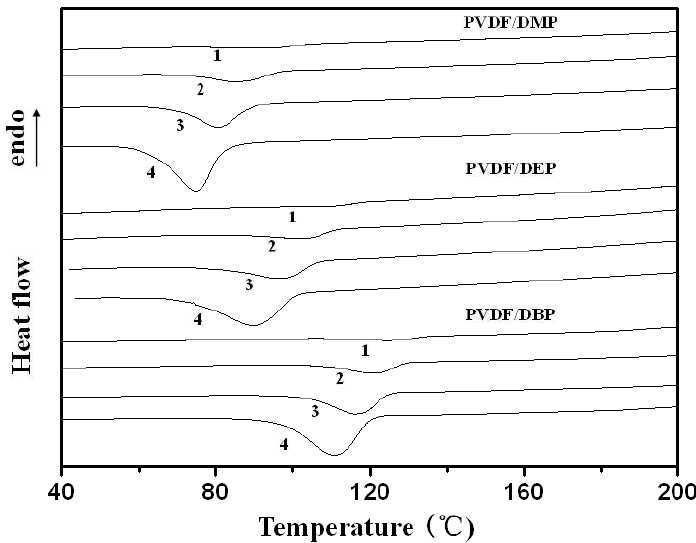
Figure 1. Differential scanning calorimetry (DSC) curves of the non-isothermal crystallization of Poly(vinylidene fluoride) (PVDF)/dialkyl phthalate blends at different cooling rates: (1) 2, (2) 5, (3) 10 and (4) 20 °C/min.